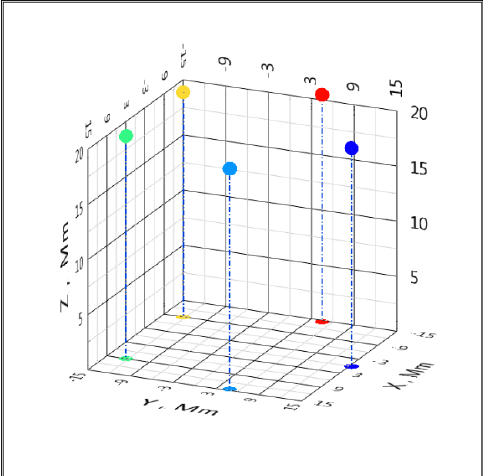
Figure 8. Simplified model of the location (1 megameter (Mm) = 10 6 m) of satellites (red) and a target on Earth (blue) in a GPS positioning system.